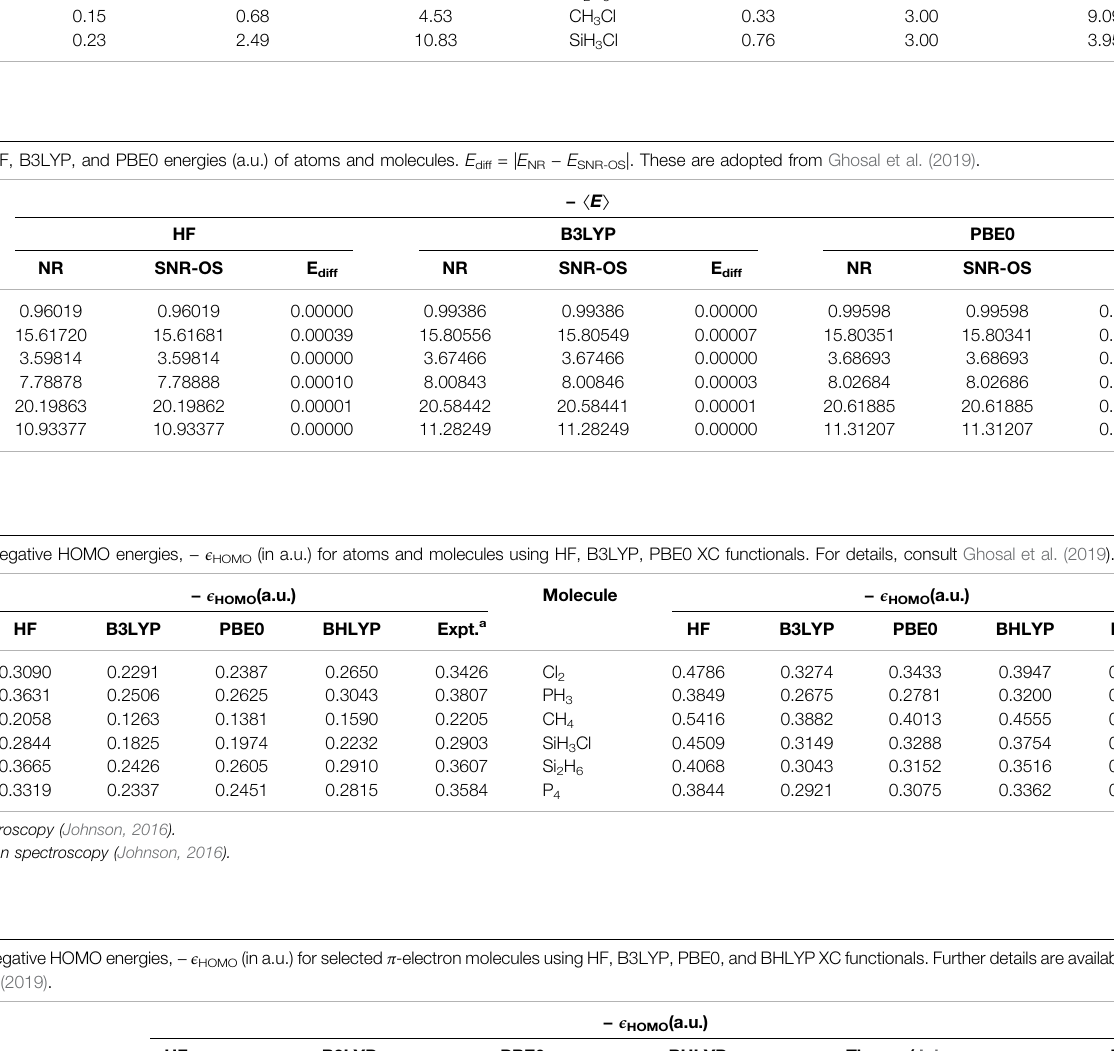
TABLE 9 | Negative HOMO energies, − ϵ HOMO (in a.u.) for selected π -electron molecules using HF, B3LYP, PBE0, and BHLYP XC functionals. Further details are available in Ghosal et al. (2019). Molecule −  HOMO (a.u.) HF BHLYP